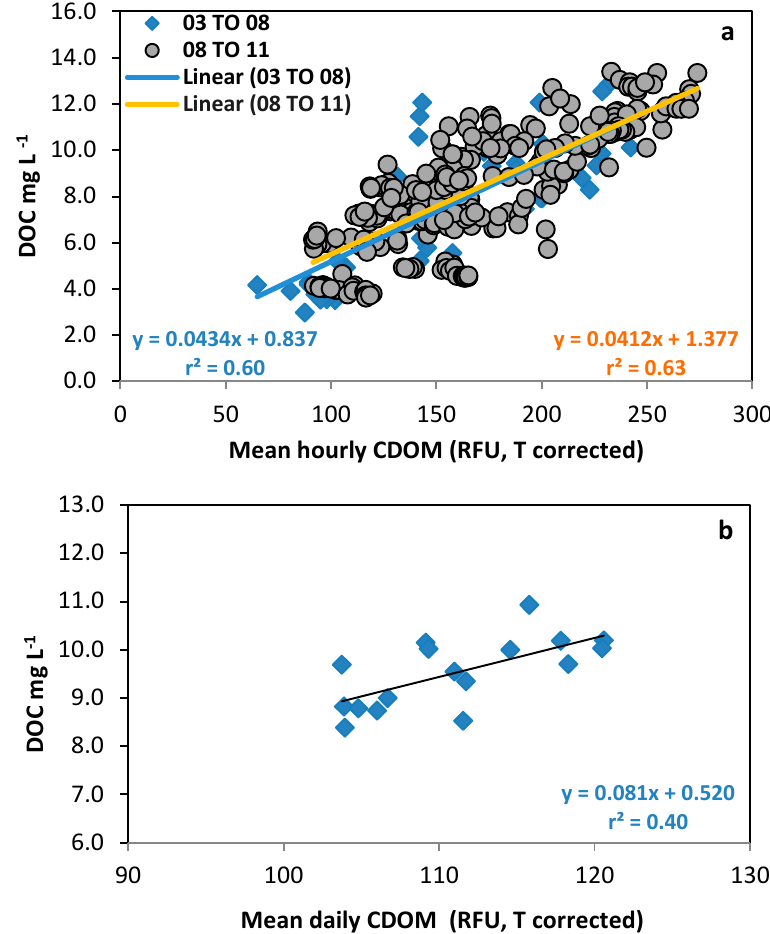
Figure 2. ( a ) Relationships between dissolved organic carbon (DOC) concentration and mean hourly CDOM fluorescence for the Glenamong River which were used to convert hourly CDOM data to estimated DOC concentrations for G1 from 2003 to 2008 (blue) and for G2 data from 2008 to 2011 (orange); ( b ) relationship between DOC concentration and mean daily CDOM fluorescence used to convert hourly CDOM data to estimated DOC concentrations for Lough Feeagh (F1) for 2010–2011. Note the differences in scale between a. and b.